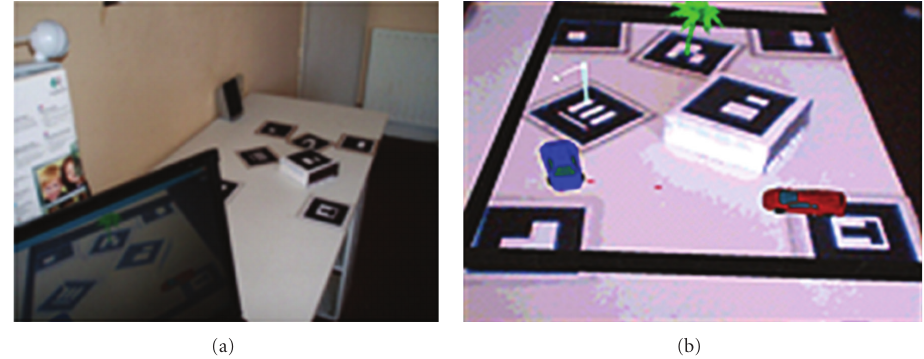
Figure 5: The setup of the table-top car racing game and two screenshots of the game viewed with augmentations.